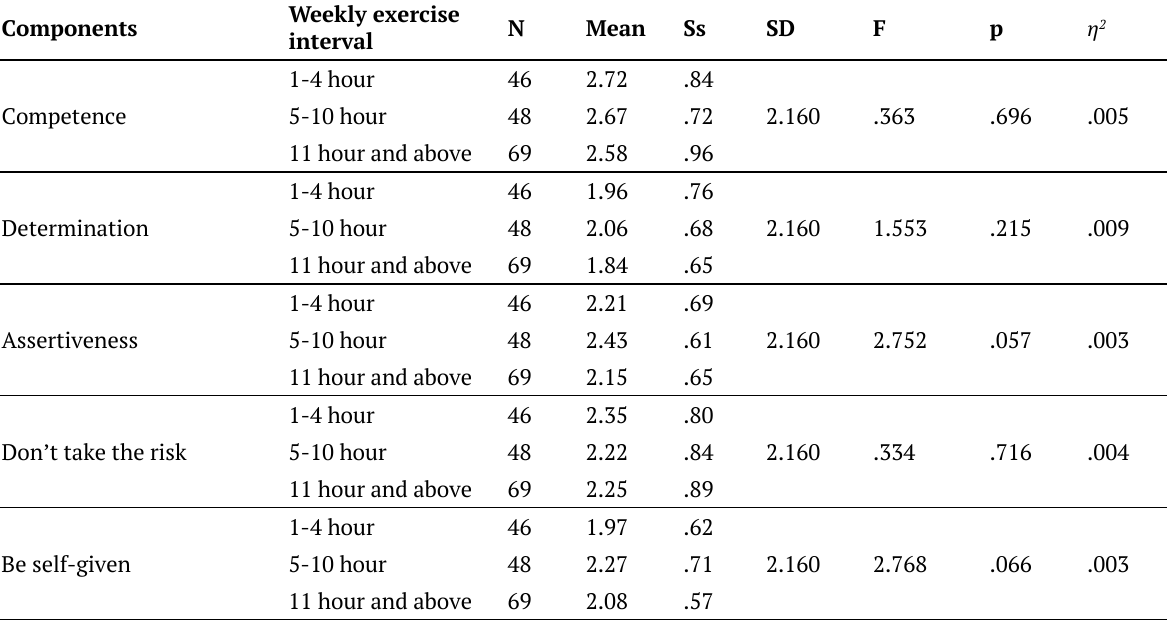
Table 5. ANOVA results of courage and sub-dimensions in sports according to the variable of weekly exercise interval